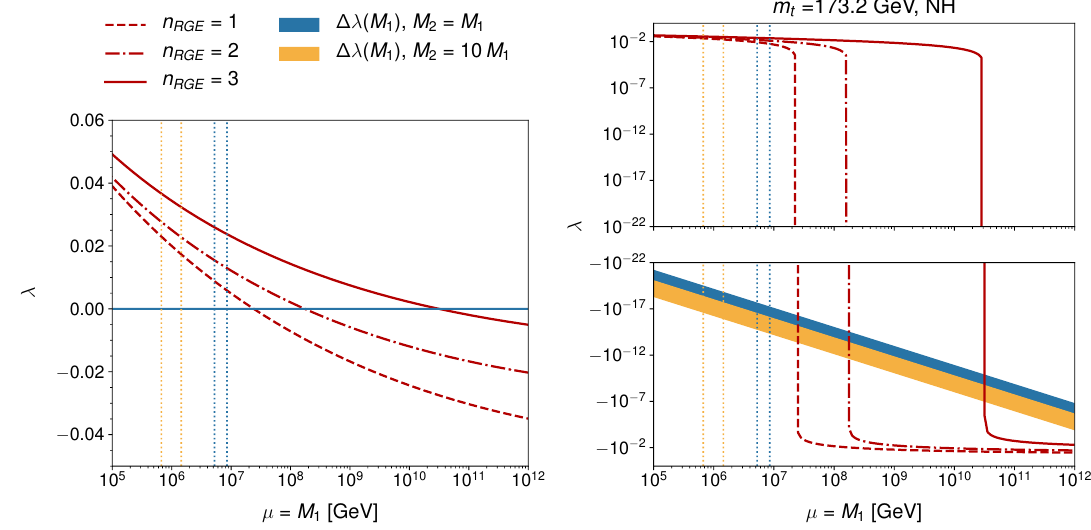
Figure 4 . Numerical comparison between the values of the threshold correction (cid:1) (cid:21) ( M 1 ) compatible with neutrino physics constraints in the degenerate M 1 = M 2 case (blue band) and when M 2 = 10 M 1 (orange band) with the running quartic coupling (cid:21) ( (cid:22) ) determined by the SM RGE and the measured SM parameters (red lines). The blue and orange bands overlap completely in the left plot. The left and right plots di(cid:11)er uniquely in the choice of the y -axis scale (linear vs. logarithmic) and the right (cid:12)gure has been split in two symmetric panels for (cid:21) > 0 and (cid:21) < 0. The dotted vertical lines mark the mass regions where the matching for m 2 is ful(cid:12)lled (cf. (cid:12)gure 3) for both the degenerate (blue) and non-degenerate (orange) cases. This (cid:12)gure assumes normal ordering of neutrino masses (NH) and ^ m t = 173 : 2